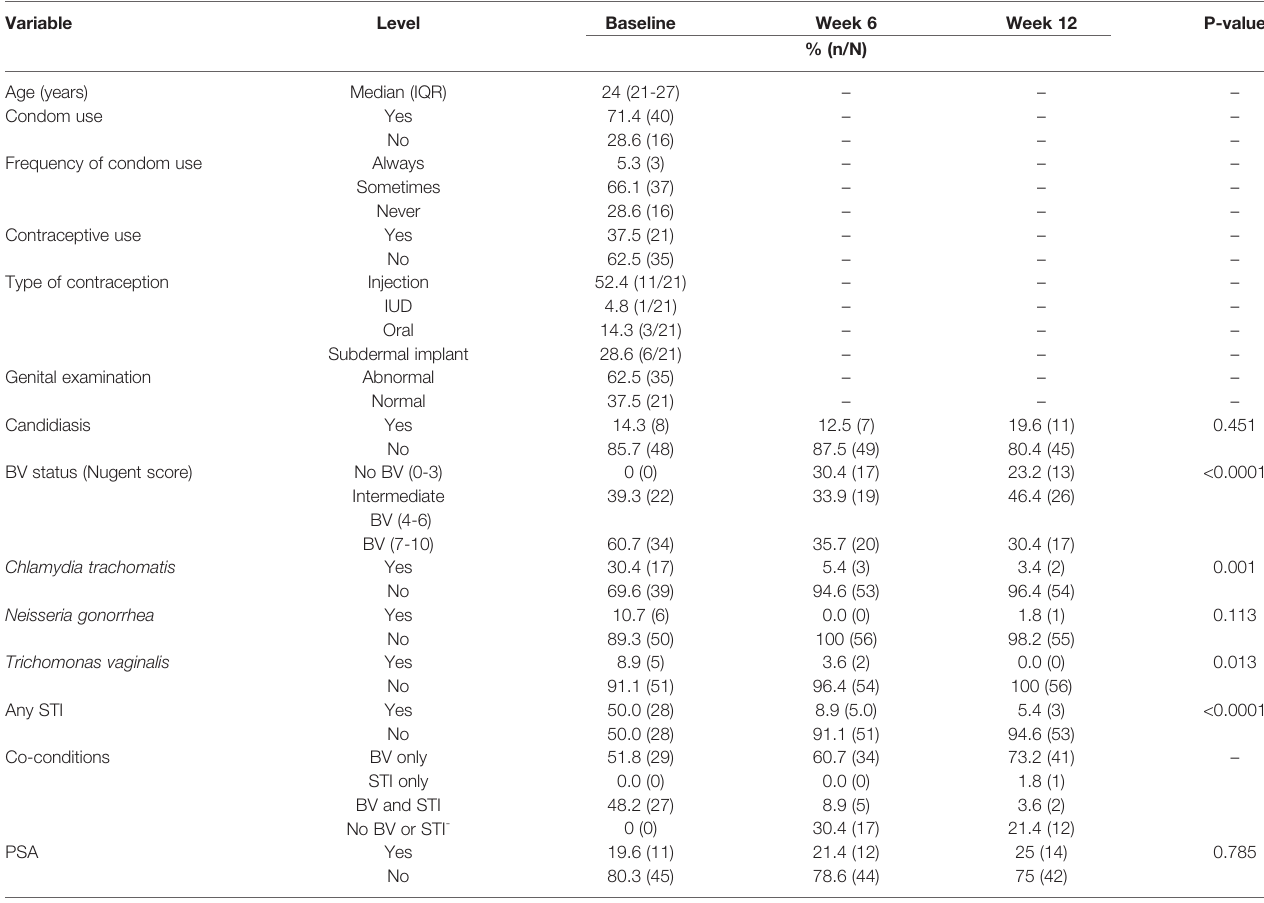
TABLE 1 | Clinical characteristics of study population at baseline and follow-up